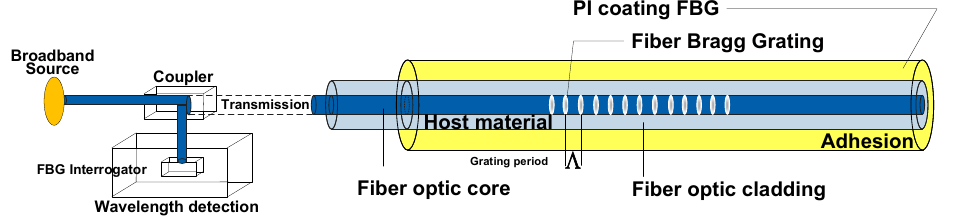
Figure 1. Measuring principle of FBG temperature sensor.